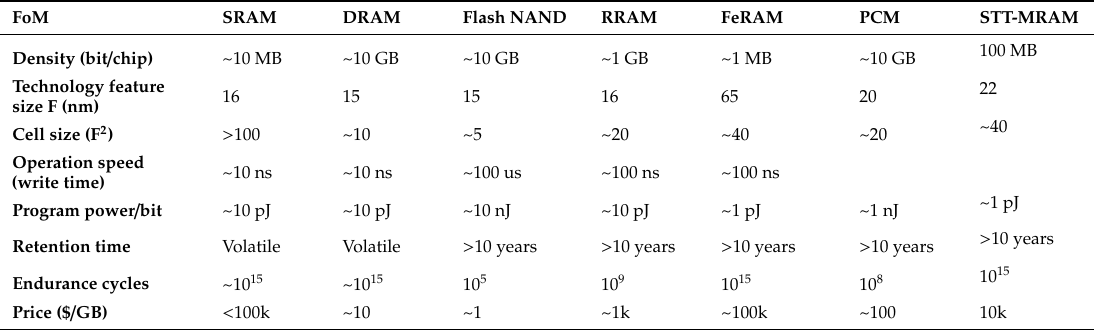
Table 3. Figure of merit (FoM) comparison among main conventional and emerging memory devices [15,79–89]. FoM SRAM DRAM Flash NAND Density (bit /